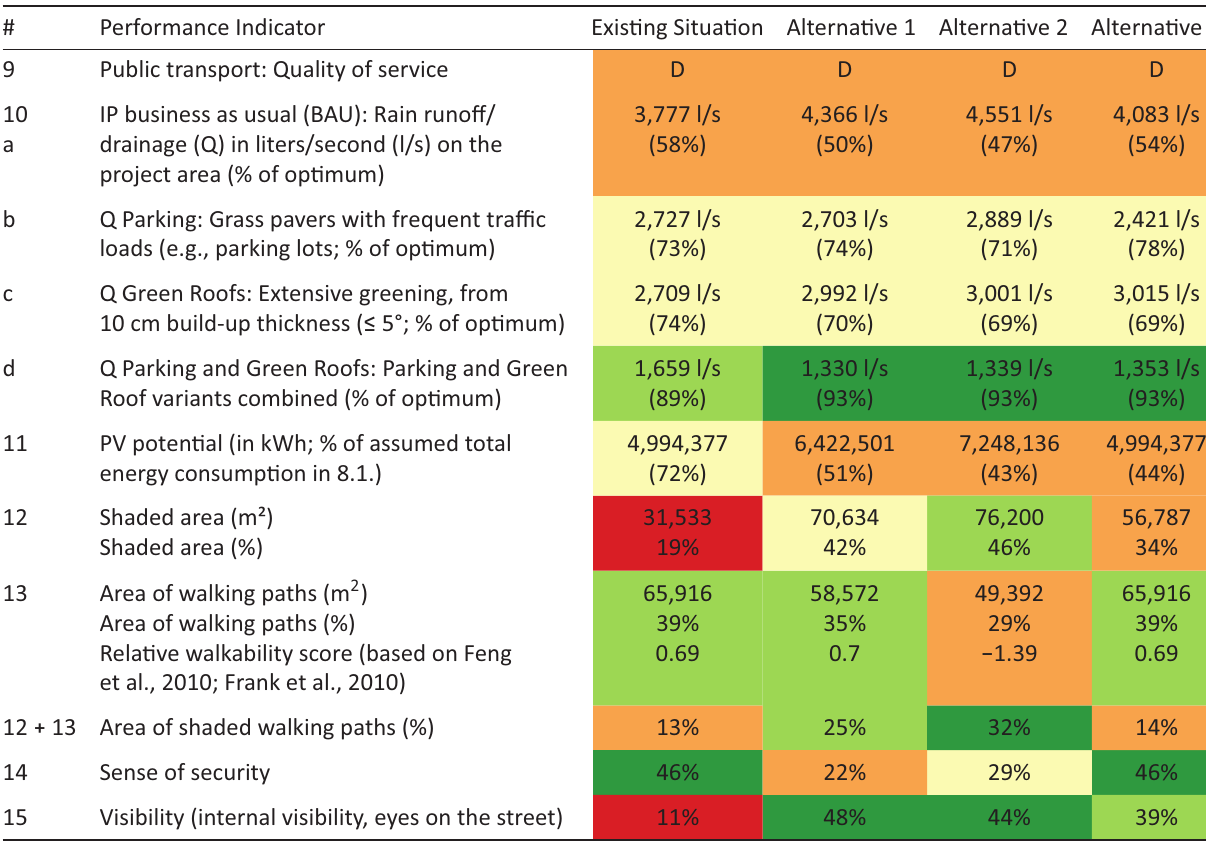
Table 4. Results: Performance indicators of design